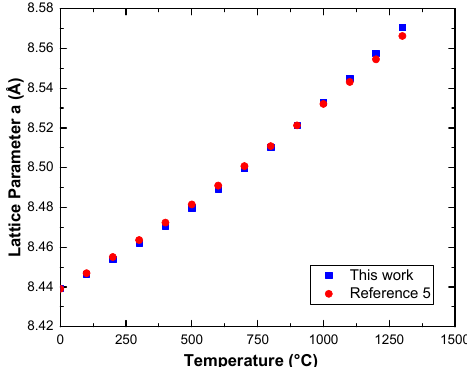
Figure 4. Calculated lattice parameters of Mg 2 TiO 4 versus temperature, derived from Equations (9) and (10).